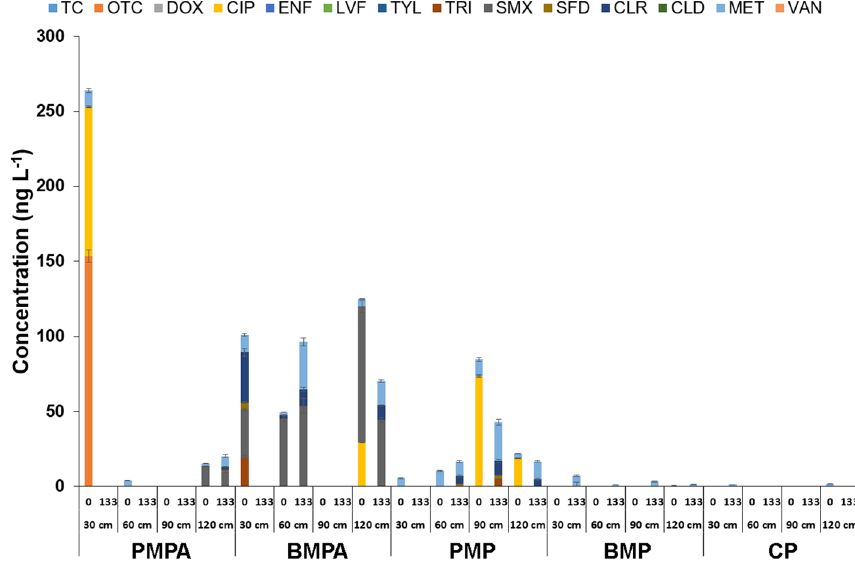
Figure 3. Antimicrobial agents content in pore water before soil enrichment AMs (A) on day 0 and (B) on the last day of the experiment (after 133 days) at different sampling depths (30–120 cm) (PMPA—soil plots supplemented with poultry manure and AMs; BMPA—soil plots supplemented with bovine manure and AMs; PMP—poultry manure soil plots; BMP—bovine manure soil plots; CP—control plots without supplementation (manure or AMs).